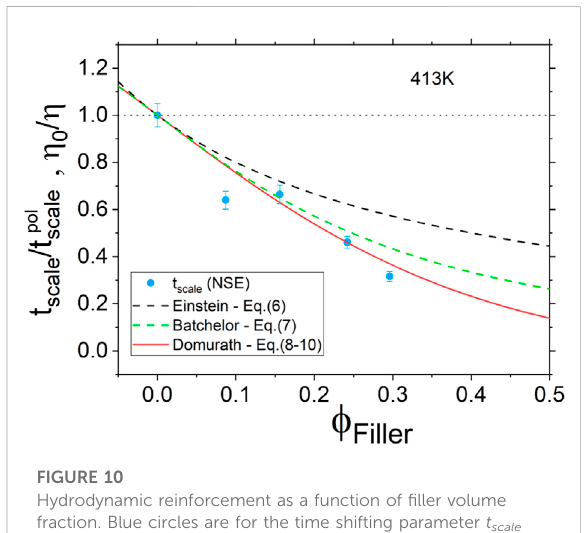
FIGURE 11 ISFs of sample I (empty circles) and sample VIII ( fi lled